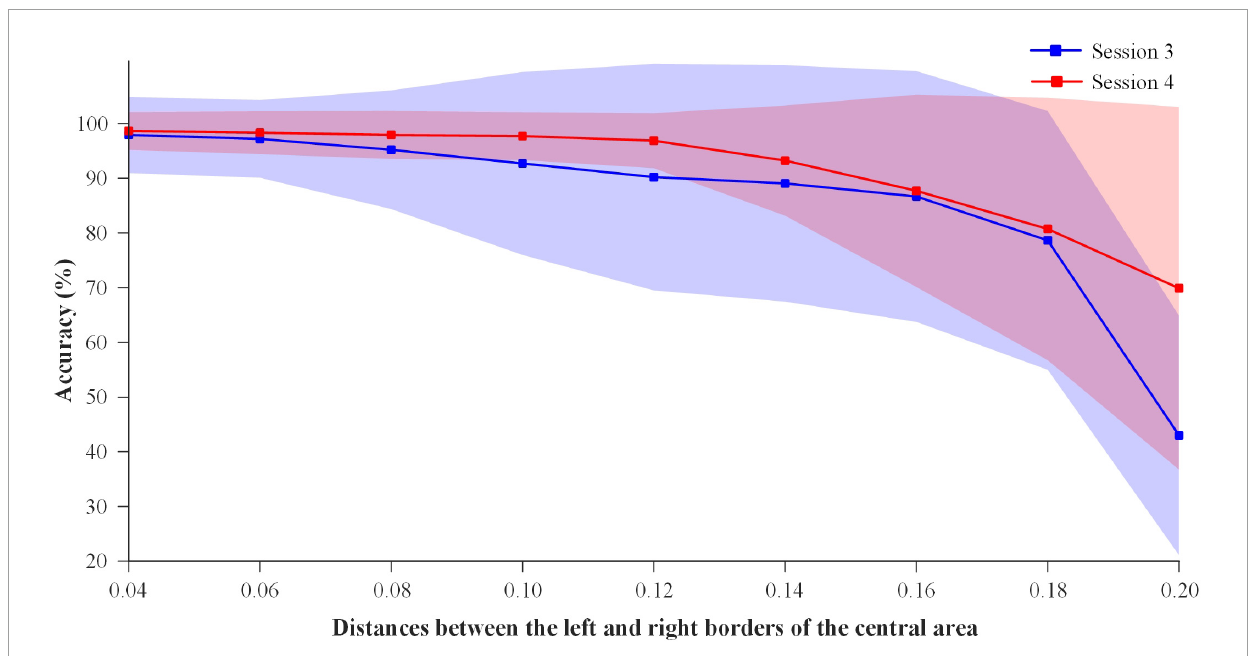
FIGURE8 Detection accuracy of the left and right stimulus areas for sequential mode in the offline